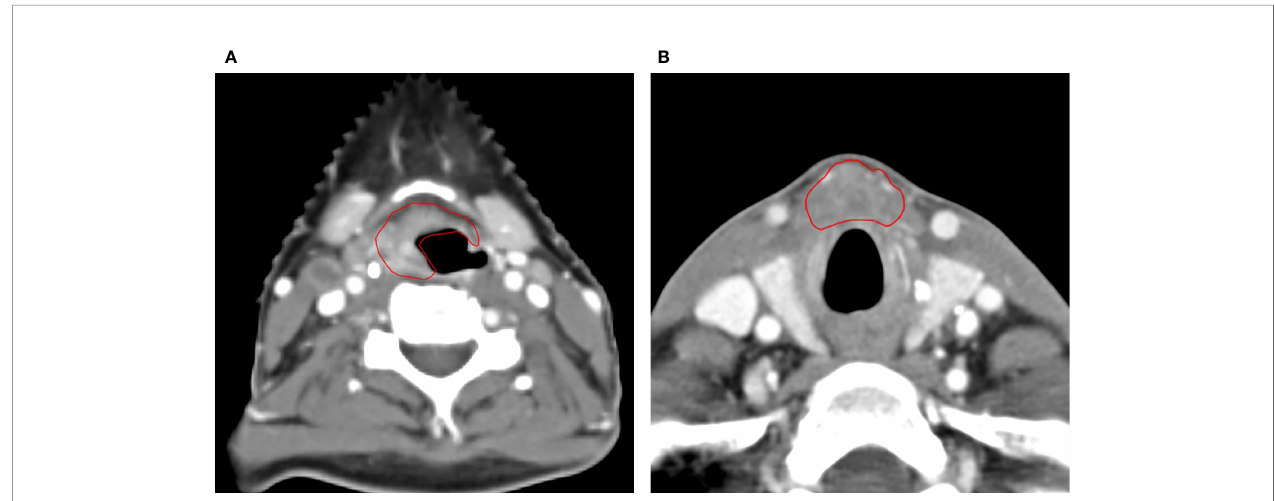
FIGURE 2 | Axial CT scan images of the only patient with a local recurrence outside of the high-dose volume. (A) The primary tumor originating in the vallecula and (B) CT scan of the local recurrence in the prelaryngeal space, approximately 1 cm caudal of the index